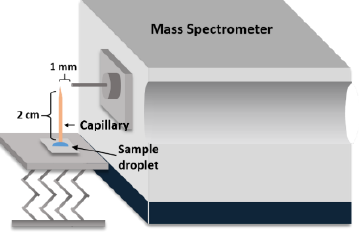
Figure 1. ( A ) Photograph of the tapered silica capillary. ( B ) Optical microscopic image of the gold- coated